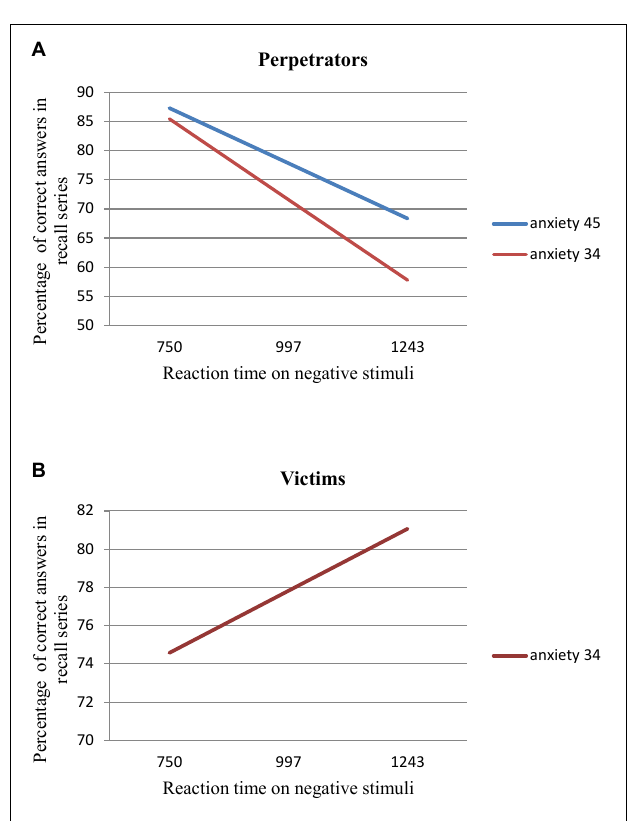
FIGURE 4 | (A,B) The moderation effect of the anxiety on the relation between the percentage of the correct answers in recall series and reaction time on negative